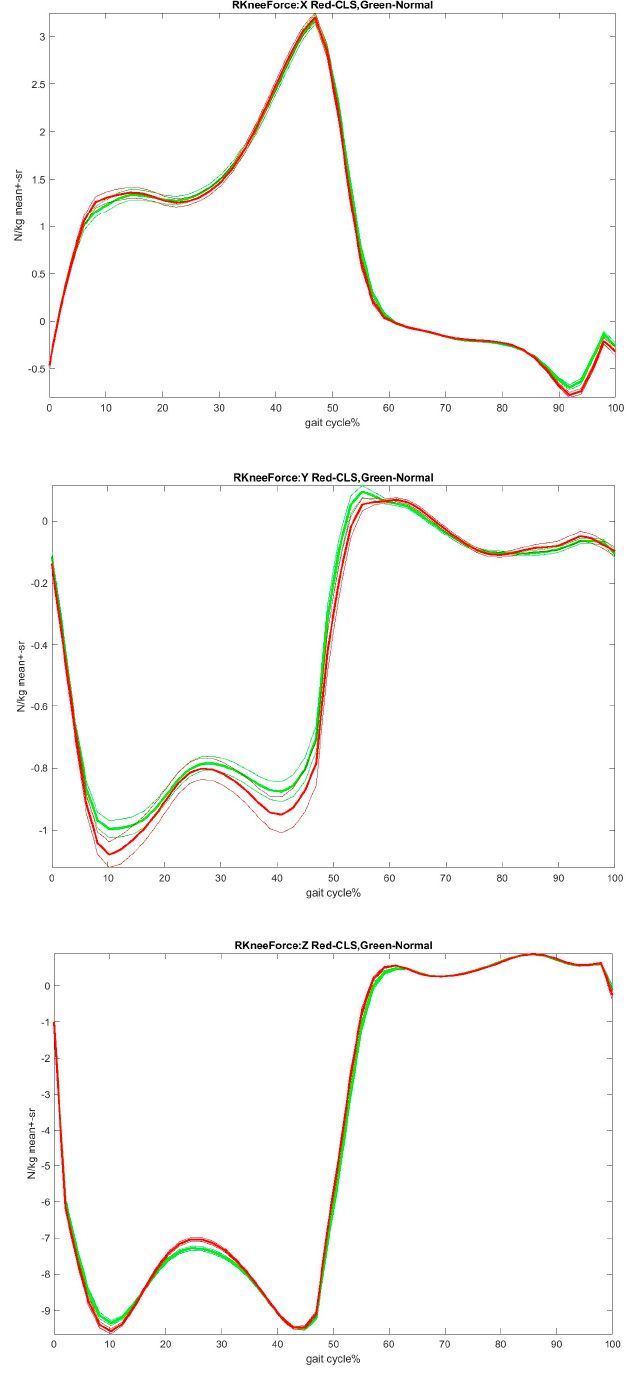
Figure 5. Knee forces’ comparison between before and after CLS in right side. Note: Green: before CLS, Red: after CLS; X, Y, and Z: the anterior-posterior, medial-lateral, and vertical directions. Thickness lines: mean, fine lines: standard error of mean. The curve patterns were plotted using right side 118 pair trials for before and after CLS, and some trails with gaps were removed. As the trails used to plot figures were resampled to 50 frames, there are slightly numeric differences between figures and tables. Nevertheless, the figures show the trends between before and after